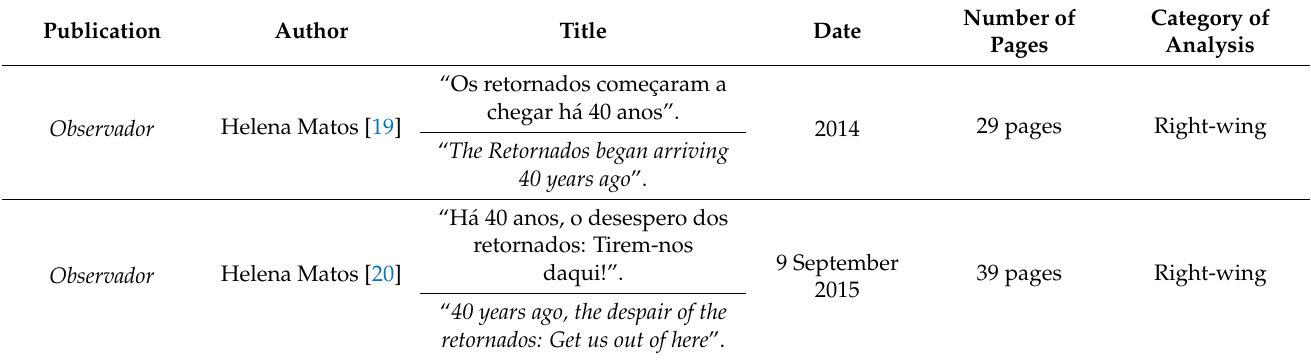
Table 1. List of articles used in the